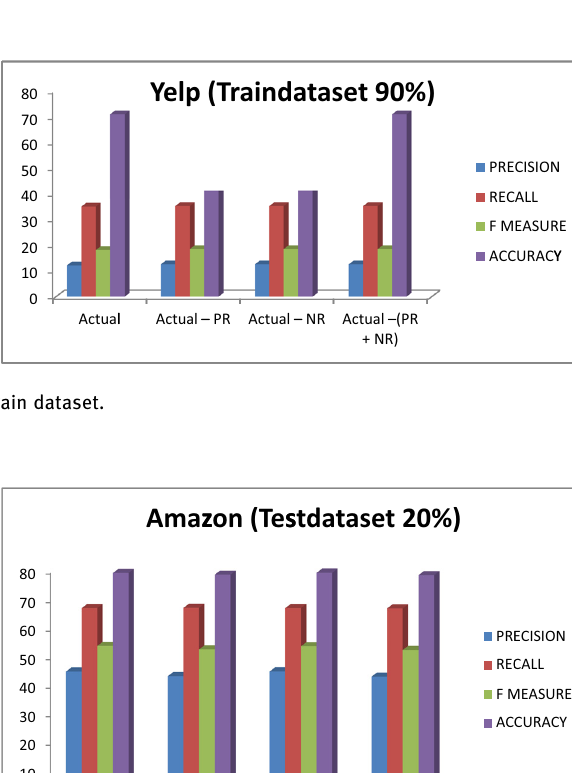
Figure 2: Plot for Amazon 90% train dataset.